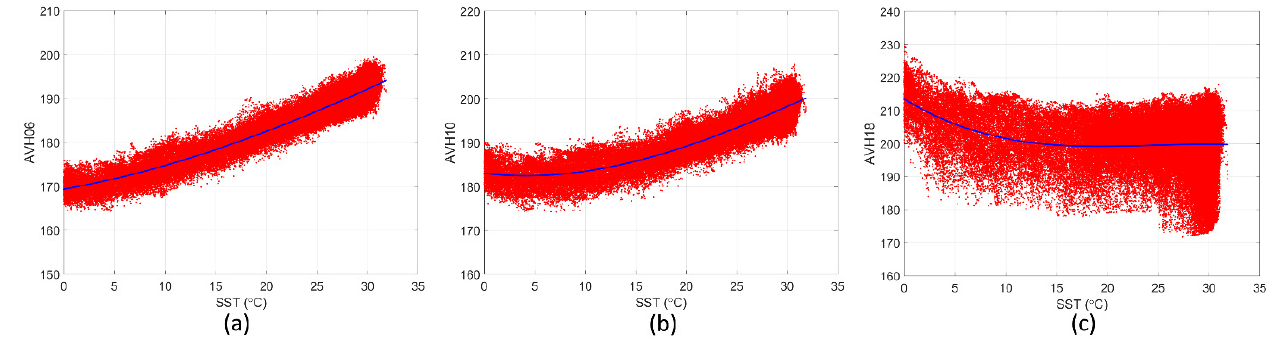
Figure 8. Finally, subtracting the results estimated by A 0x ( SST ) and F ( Ws , ϕ ) from the AVH measurements allows us to obtain the function of the A 0z coefficient, which is derived by linear fitting PR06 at various wind speeds. Figure 9 presents the coefficients A 0z versus PR06 at 6.925 GHz, 10.7 GHz, and 18.7 GHz, respectively. The PR06 dependence is very strong for high frequency, with the dynamic range of A 0z larger than 80 K approximately at 18.7 GHz. The dependence at low frequencies is relatively small, but still cannot be neglected. Figures 8 and 9 indicate that the AVH at high frequency is very sensitive to wind vector and rain effect; thus, if we can model the contribution of wind vector and rain well, AVH is very helpful to retrieve the sea surface wind vector under rainy conditions.